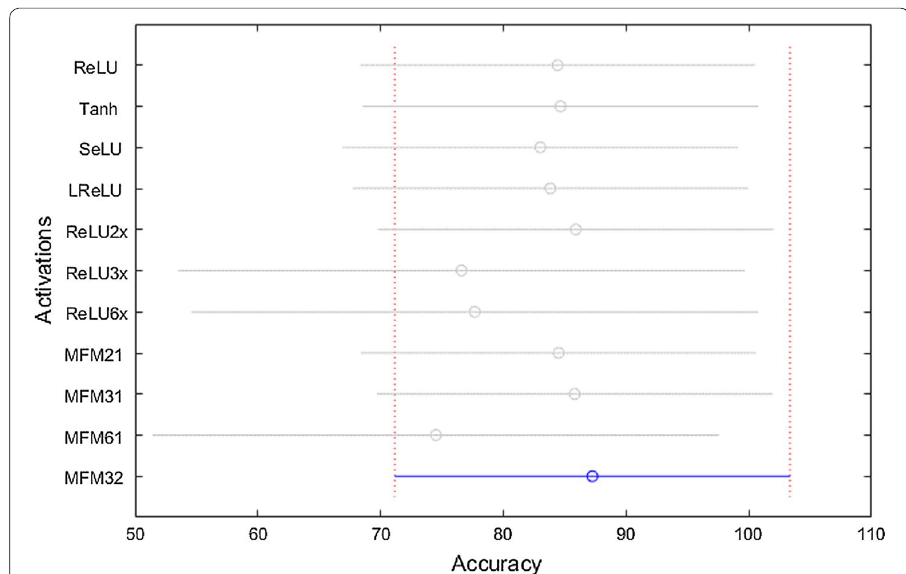
Fig. 15 Multiple comparisons, activations on face datasets